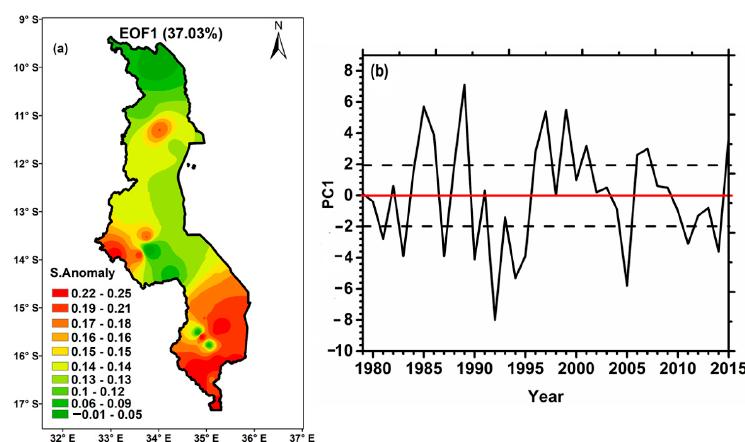
Figure 4. EOF 1 of the wet season precipitation. ( a ) Spatial variability and ( b ) its corresponding PC over Malawi based on data from 31 rainfall stations during 1979–2015.